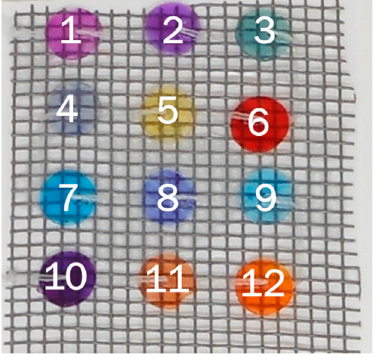
Figure 1. Example of the 3 × 4 sensing platform used as a chemometric-assisted litmus test (CLT). Dye-EVOH@ sensors are numbered from 1 to 12, according to the numbering in Table 1. Table 2. Solutions used for the training samples (A–O).